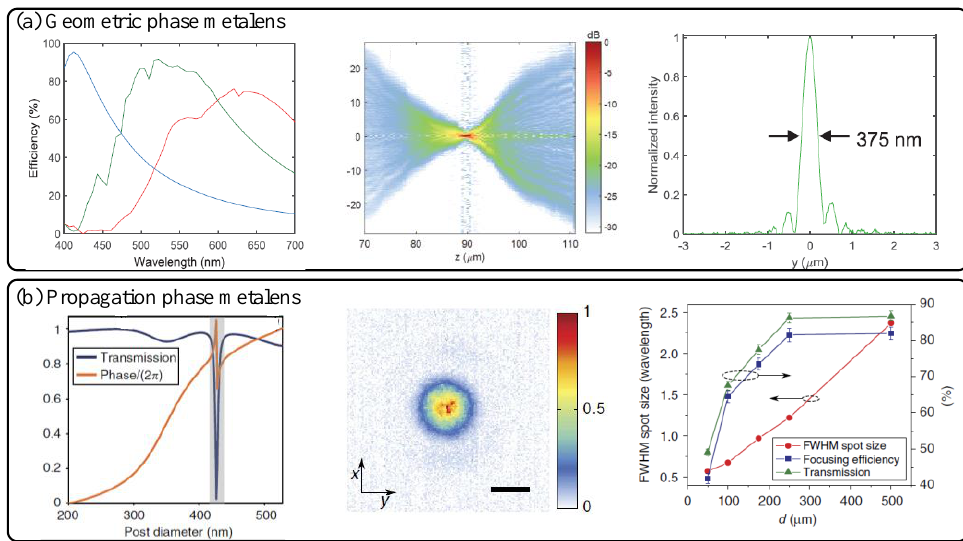
Figure 2. Similar high numerical aperture (NA) diffraction-limited on-axis focusing performances of ( a ) the geometric phase based nanofin metalens by F. Capasso group [9] and ( b ) the propagation phase based isotropic nanopost metalens by the A. Faraon group [10]. The left sub-figure in ( a ) shows cross-polarization efficiency of the three types of TiO 2 nanofin pixels. The central sub-figure of ( a ) shows measured focusing map in image space, and the right sub-figure refers to the cross-sectional point spread function at the focal point (NA: 0.8) while the collimated incident light with the wavelength of 532 nm is illuminated. In ( b ), transmission amplitude and phase response of the a-Si nanopost ( left ) according to diameter variation, point spread function at the focal point ( center ), and image position ( d ) dependent plots of focal spot size and efficiency ( right ), at the wavelength of 1550 nm, respectively. In the rightmost figure in ( b ), increase of designed d implies decrease of NA and increase of focal length. The scale bar of the central point spread function in ( b ) denotes 1 μ m. ( a ) Reprinted with permission from [9]. Copyright 2016 The American Association for the Advancement of Science. ( b ) Reprinted with permission from [10]. Copyright 2015 Springer Nature.